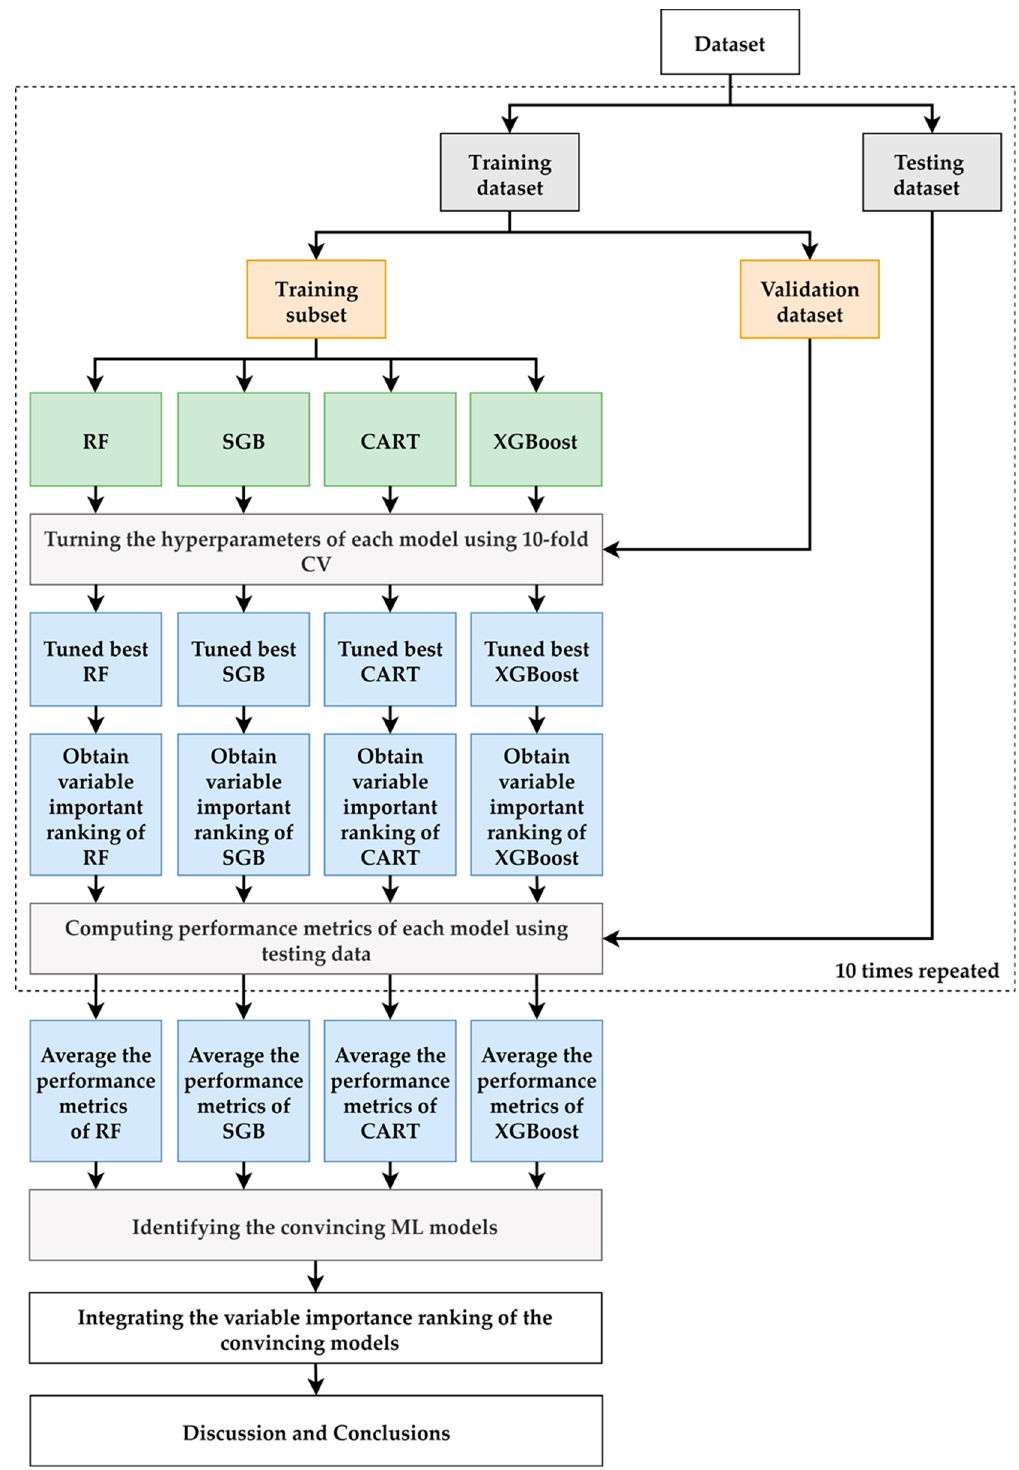
Figure 2. Proposed ML prediction scheme.